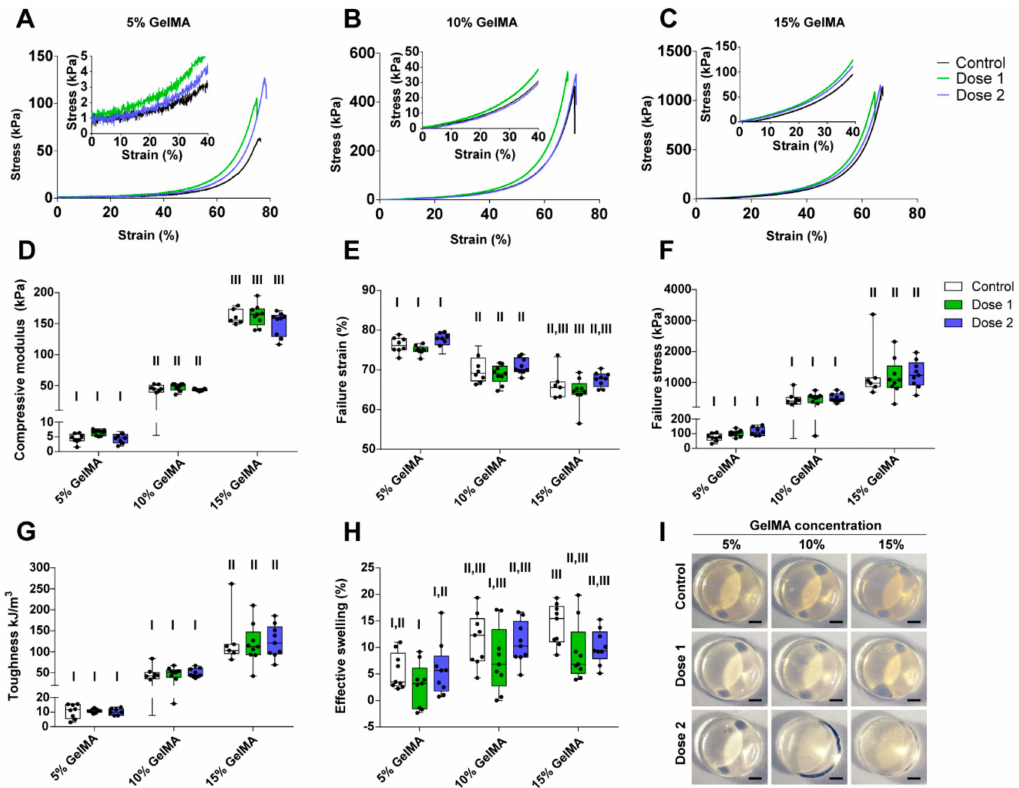
Figure 2. Characterization of the compressive and swelling properties of GelMA-DDS hydrogels for various GelMA concentrations and doses of Abraxane ® . ( A – C ) Representative stress-strain curves for 5% w / v ( A ), 10% w / v ( B ) and 15% w / v ( C ) GelMA groups. ( D ) Compressive modulus. ( E ) Failure strain. ( F ) Failure stress. ( G ) Toughness. ( H ) E ff ective swelling. ( I ) Representative images of hydrogel samples; scale bar = 1 mm. Dose 1 and 2 refer to 37.5 µ g and 75 µ g Abraxane ® , respectively. Control refers to no drug loading. Data are shown as box plots, n = 9. Groups with no statistical di ff erence are marked with the same roman numeral.